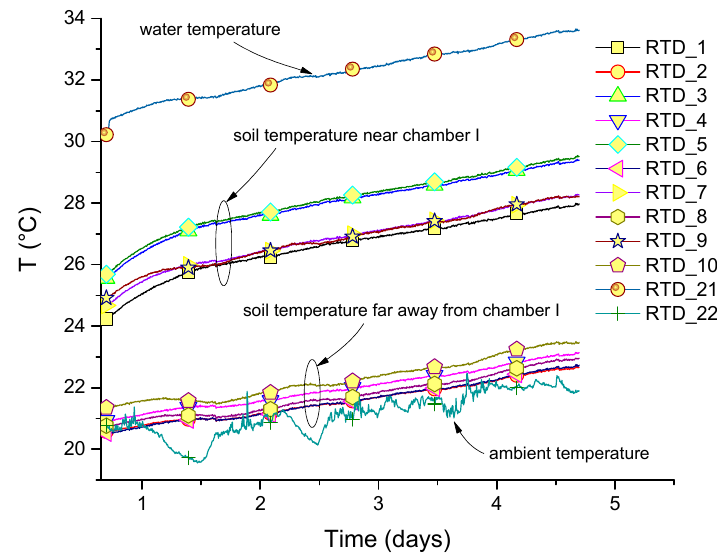
Figure 4. Time-history of soil, water, and ambient temperatures.